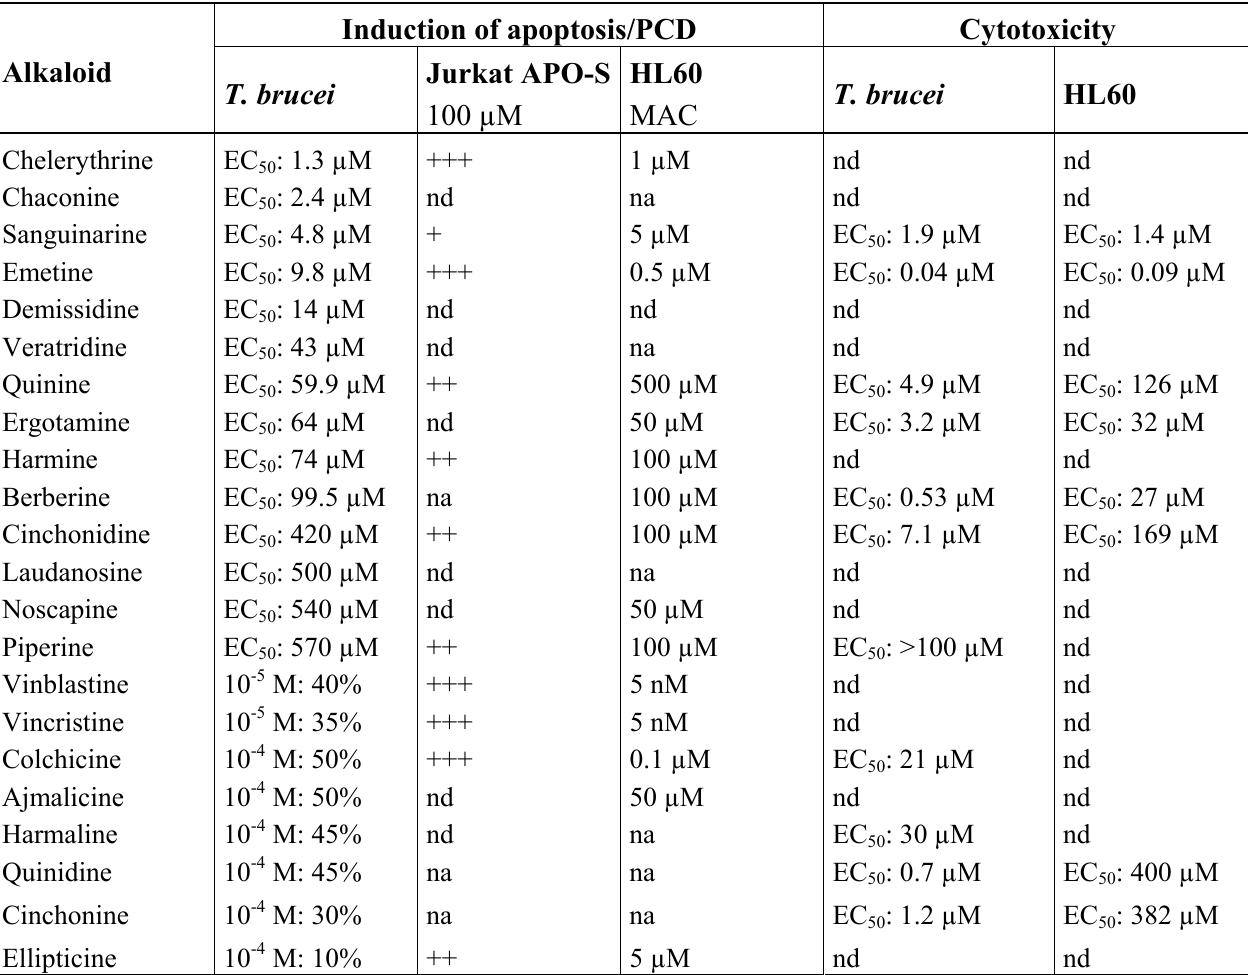
Table 2. Comparison between T. brucei and human leukemia cells (Jurkat APO-S, HL60). Data for cytotoxicity for T. brucei came from [5], those for HL60 from [5 and 6]. Induction of apoptosis/PCD Cytotoxicity Alkaloid Jurkat APO-S HL60 T. brucei 100 µM MAC